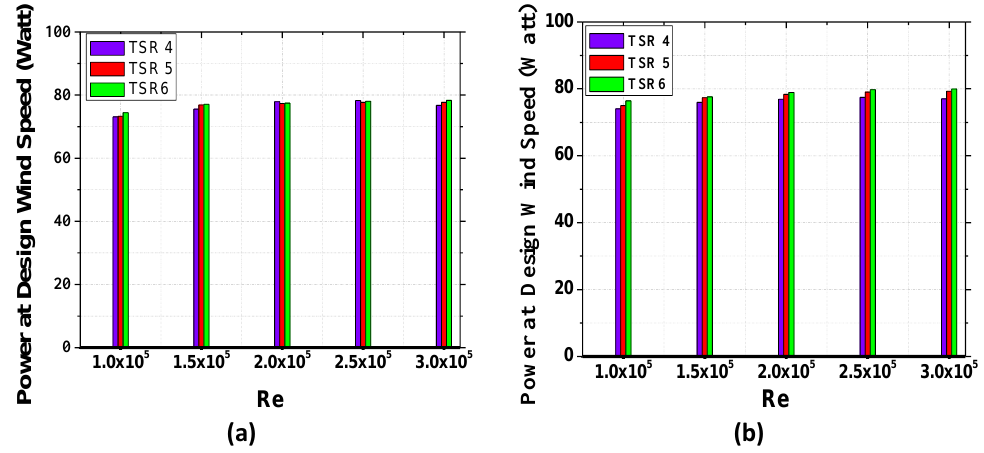
Figure 20. Power output at design wind speed ( a ) NACA 4412 rotor blade ( b ) SG6043 rotor blade.